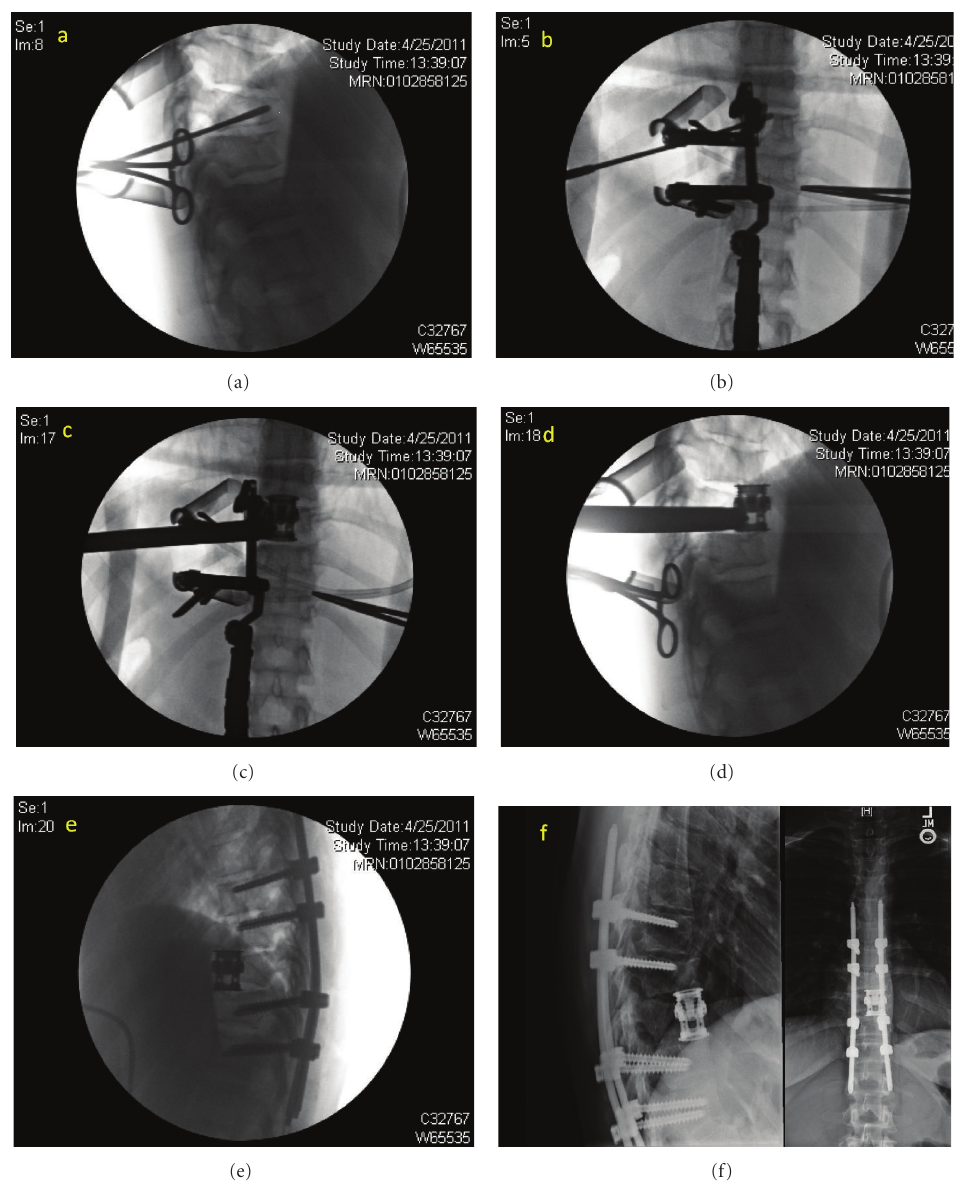
Figure 1: 24-year-old female who su ff ered a traumatic T9 fracture and underwent MIS lateral extracavitary T9 corpectomy with T7-T11 posterior segmental instrumentation—Sequential intraoperative and postoperative images ((a)–(f)).